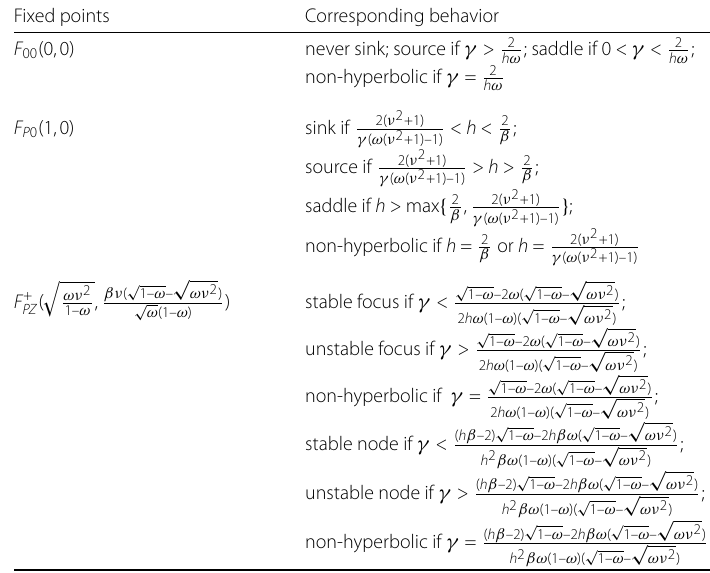
Table 2 Topological classifications around fixed points of phytoplankton–zooplankton model (8) Fixed